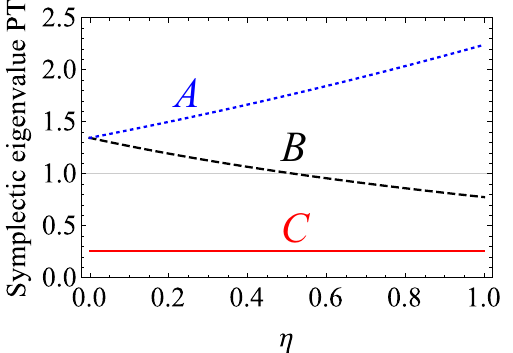
Figure 8. The dependence of smallest symplectic eigenvalues E ˆ on transmission loss η under the conditions of G 1 = G 2 = G 3 = 2 and β =